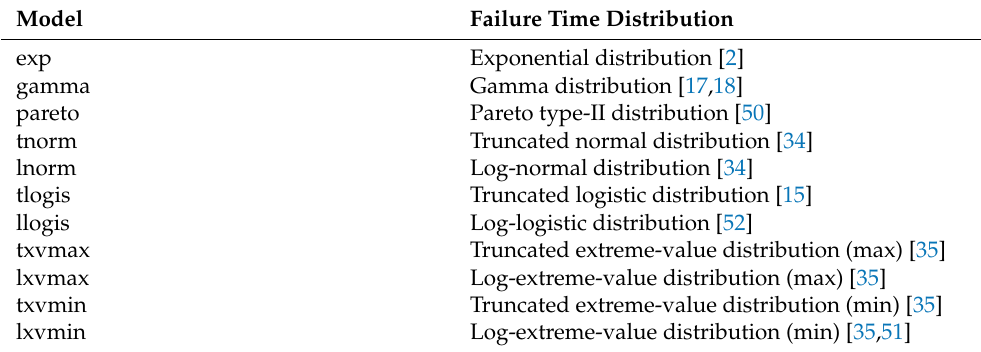
Table 1. Basic NHPP-based